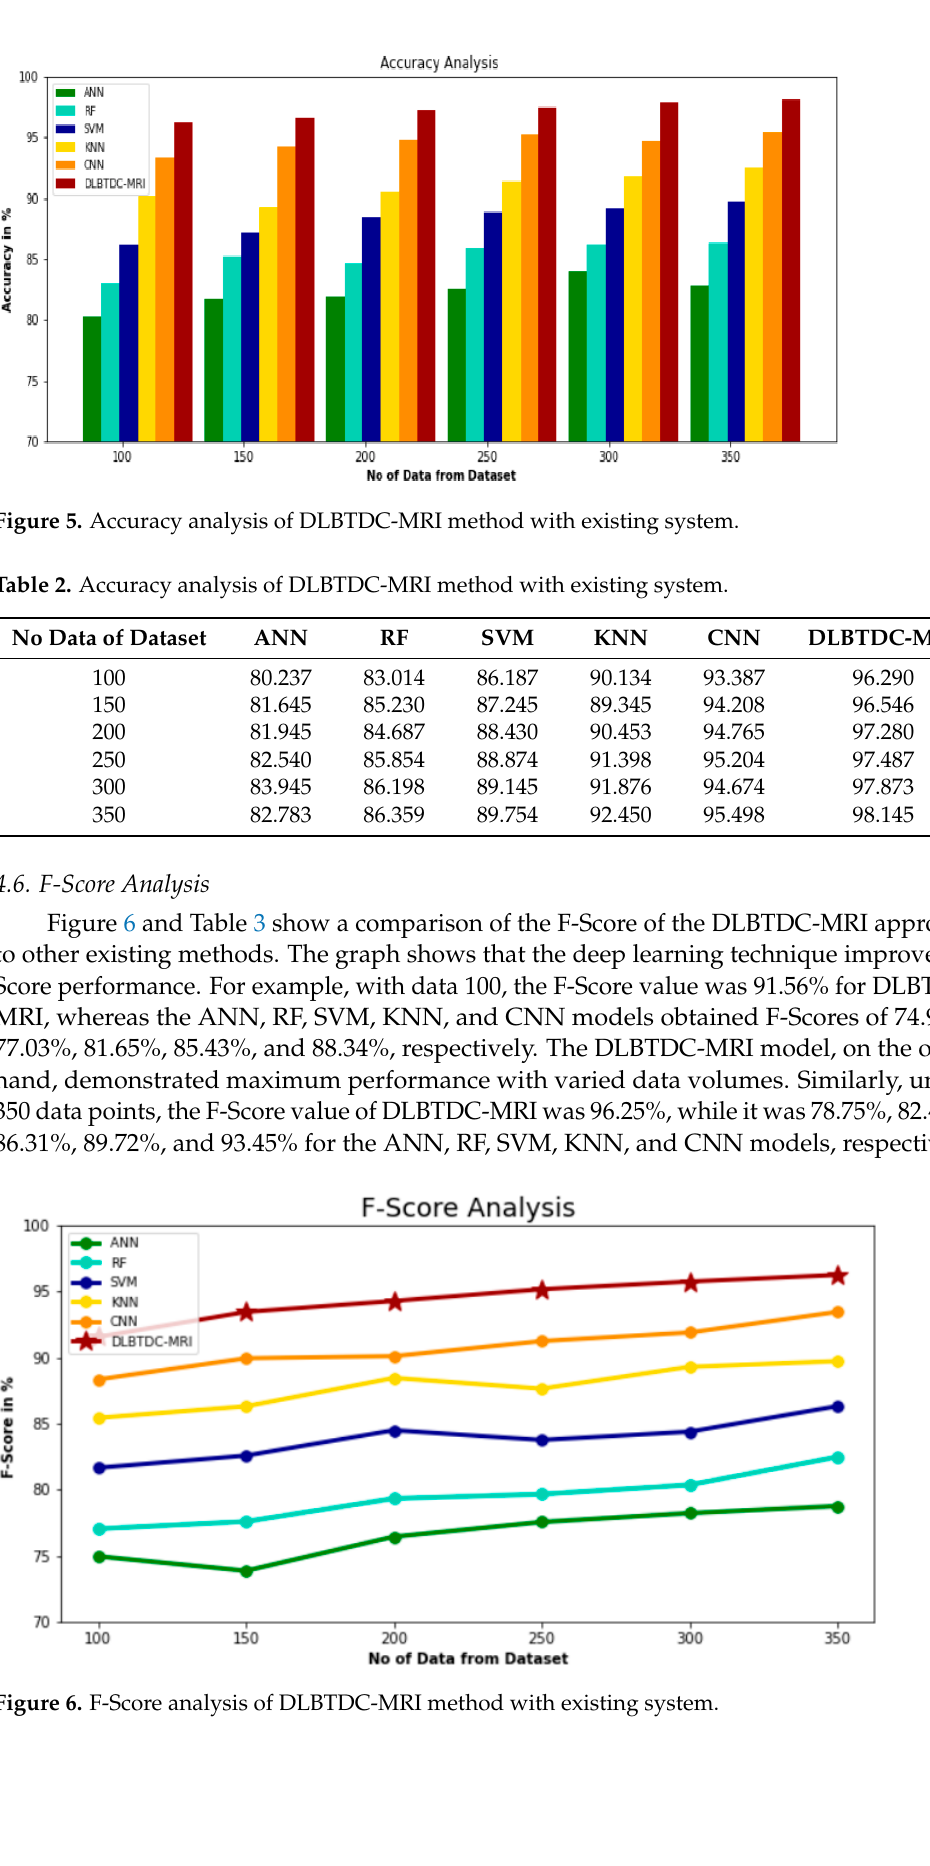
58.21 Figure 6. RMSE analysis of DLBTDC-MRI method with existing system.